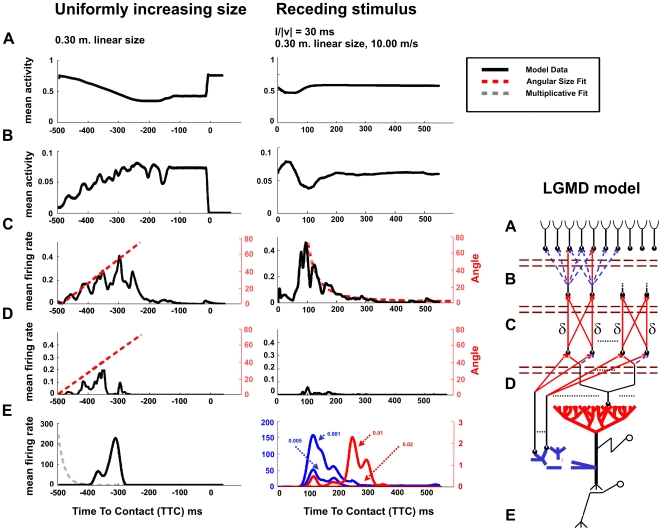
Mean population responses of the different layers of our model to a uniformly expanding or receding stimulus.The right most panel depicts the modelled anatomical organization of the pathway to the LGMD (A–E) where (A) is the photoreceptor layer, (B) the lamina (the centre/surround architecture), (C) the medulla (containing the on-off neurons), (D) the neurons connecting to the excitatory pathway of the LGMD, and (E) the LGMD/DCMD output. Left panel: Average population response for each of the layers of our model (depicted in the right most diagram) to an object that is uniformly increasing in size (10 repetitions). The curves in (E) show the different responses predicted by our model (solid line) and generated by the model proposed by Gabbiani et al. (1999) (dashed grey line) to the same stimulus. Right panel: Population responses for each of the layers of our model to receding stimuli (32 repetitions). The gain of the excitatory input to the LGMD was fixed to 0.2 while 4 different gains of the inhibition were tested (0.02, 0.01, 0.005, and 0.001). (E) shows the 4 predictions for the responses of the LGMD depending on the inhibitory weight to a receding stimulus. The input data to the LGMD was fitted with the instantaneous angular size of the object in (C) and (D) (red dashed line). The half-length of the objects for both linearly increasing and receding stimulation experiments was fixed to 30cm. In the case of the receding experiment, the simulated object was moving away from the camera at 10m/s.